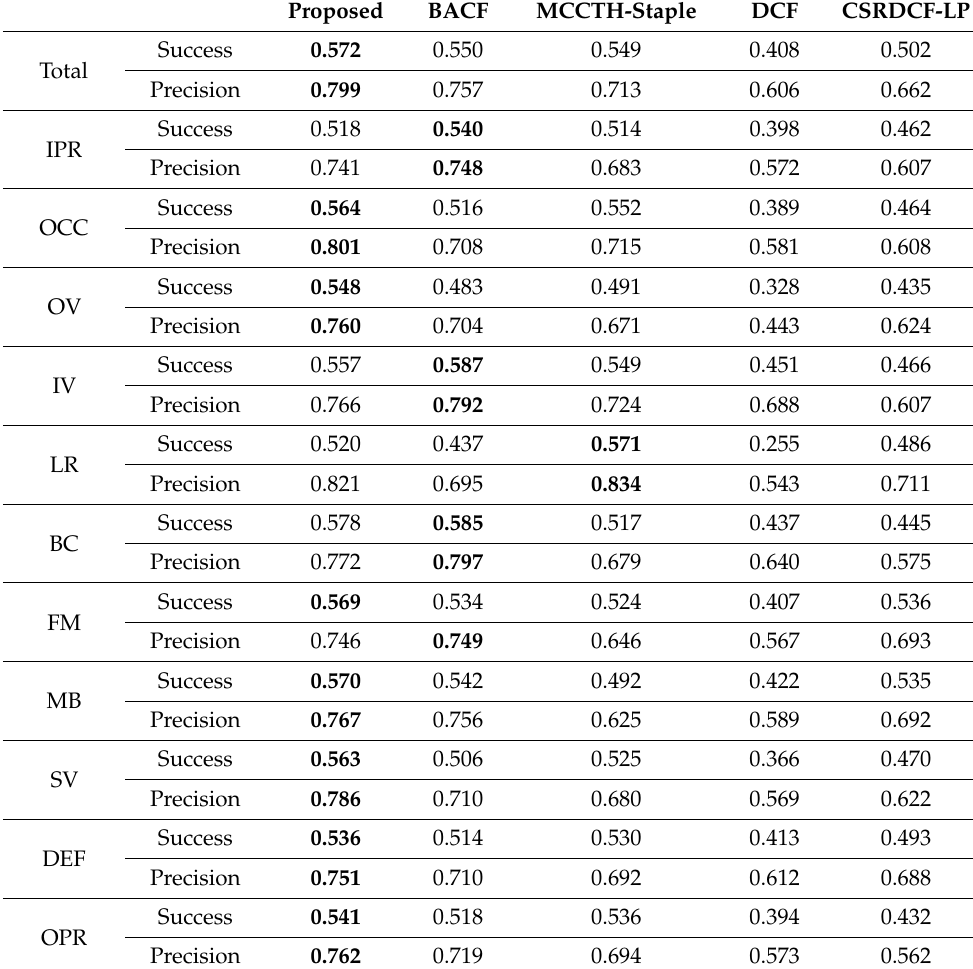
Table 6. Overall Performance Evaluation Results for Attributes of OTB-50 Benchmark Dataset.